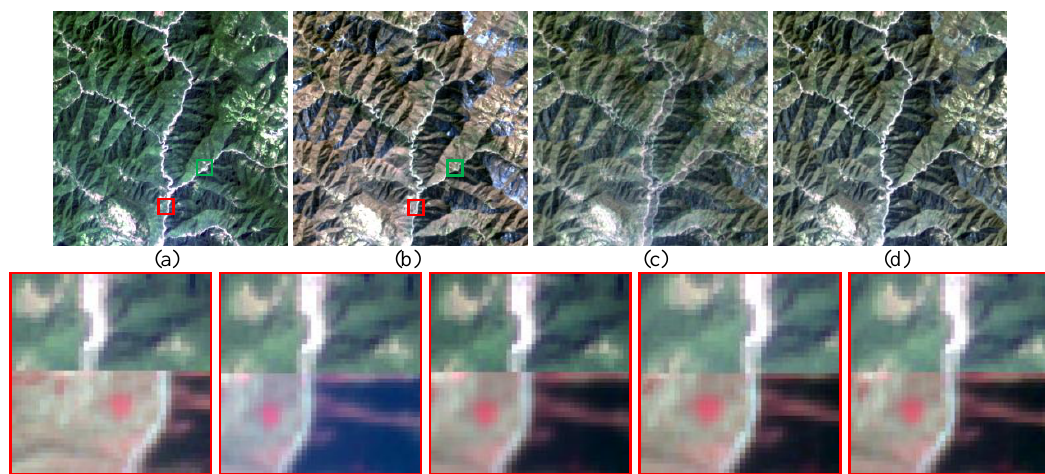
Experiment 1: The reference image is taken on February